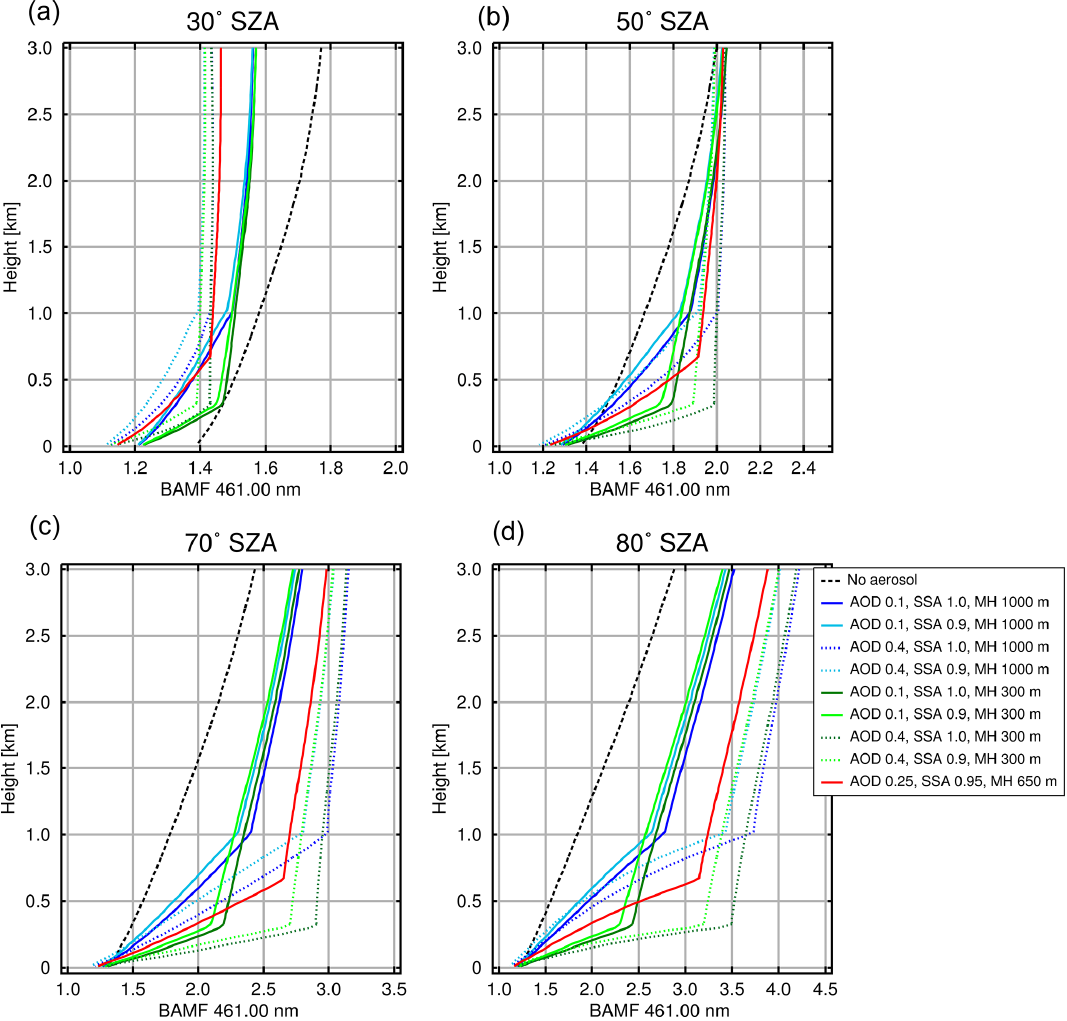
Figure 6. Simulated scenario-based tropospheric box AMFs for SZA = 30 ◦ (a) , SZA = 50 ◦ (b) , SZA = 70 ◦ (c) , and SZA = 80 ◦ (d) . The red line shows the box AMF that is based on an intermediate scenario. Other scenarios are indicated by different colors and line styles.